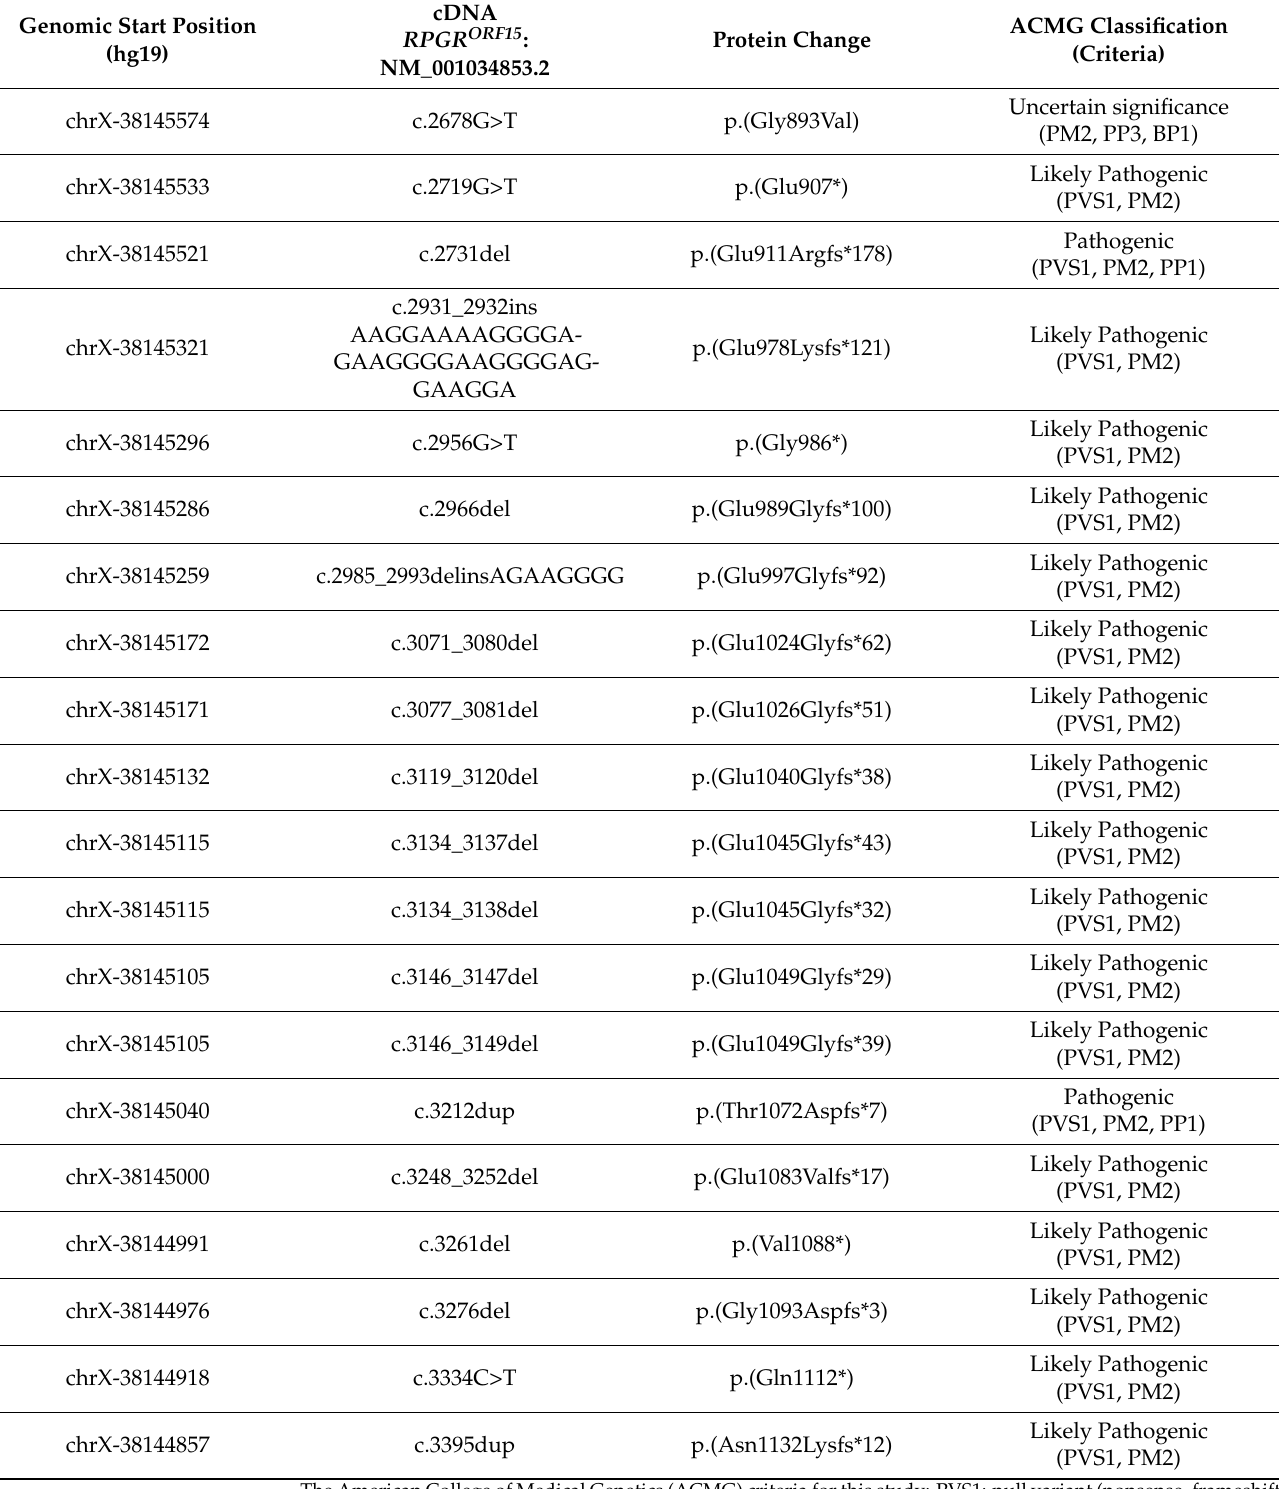
Table 2. A list of novel hemizygous RPGR ORF15 variants detected in the study. Genomic Start